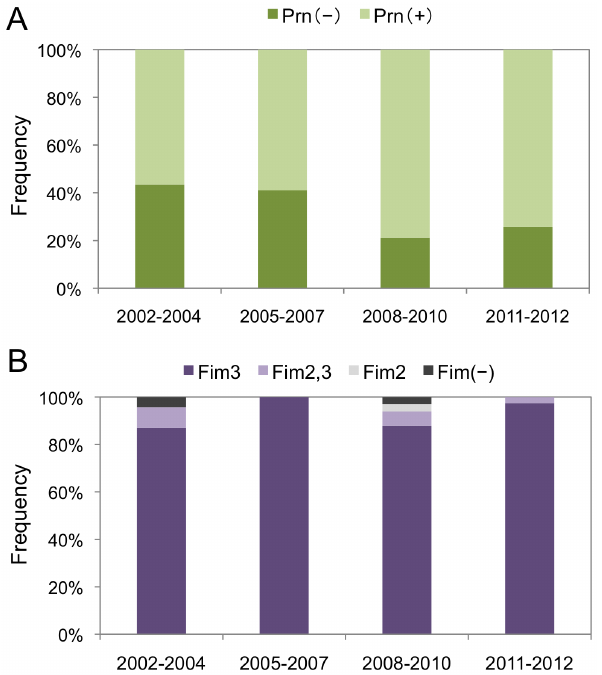
Figure 3. Temporal trends in the frequencies of Prn and Fim3 variants of Bordetellapertussis isolates in Japan from 2002 to 2012. Prn (A) and Fim (B) expression was analyzed within 134 B.pertussis isolates. Two Prn variants, Prn( + ) and Prn( 2 ), and 4 Fim variants, Fim2, Fim3, Fim2,3, and Fim( 2 ) strains, were identified. Variant frequencies are shown by time period: 2002 2 2004 (non-epidemic, n=23), 2005 2 2007 (pre-epidemic, n=39), 2008 2 2010 (epidemic, n=33), and 2011 2 2012 (post-epidemic, n=39).